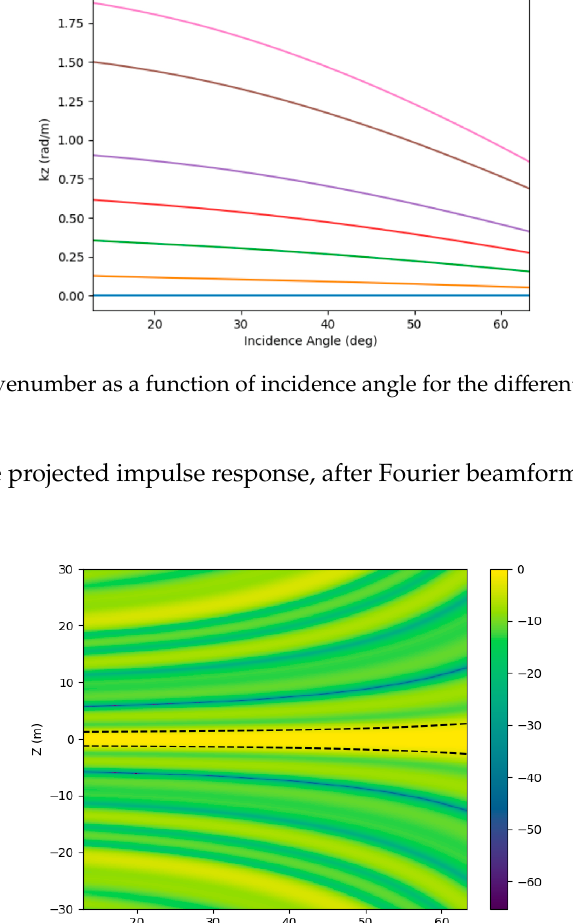
(cid:16) (cid:17) λ r · sin ( θ ) is of about 2.8 m in the near range 1 /2 D Tomo PLOS